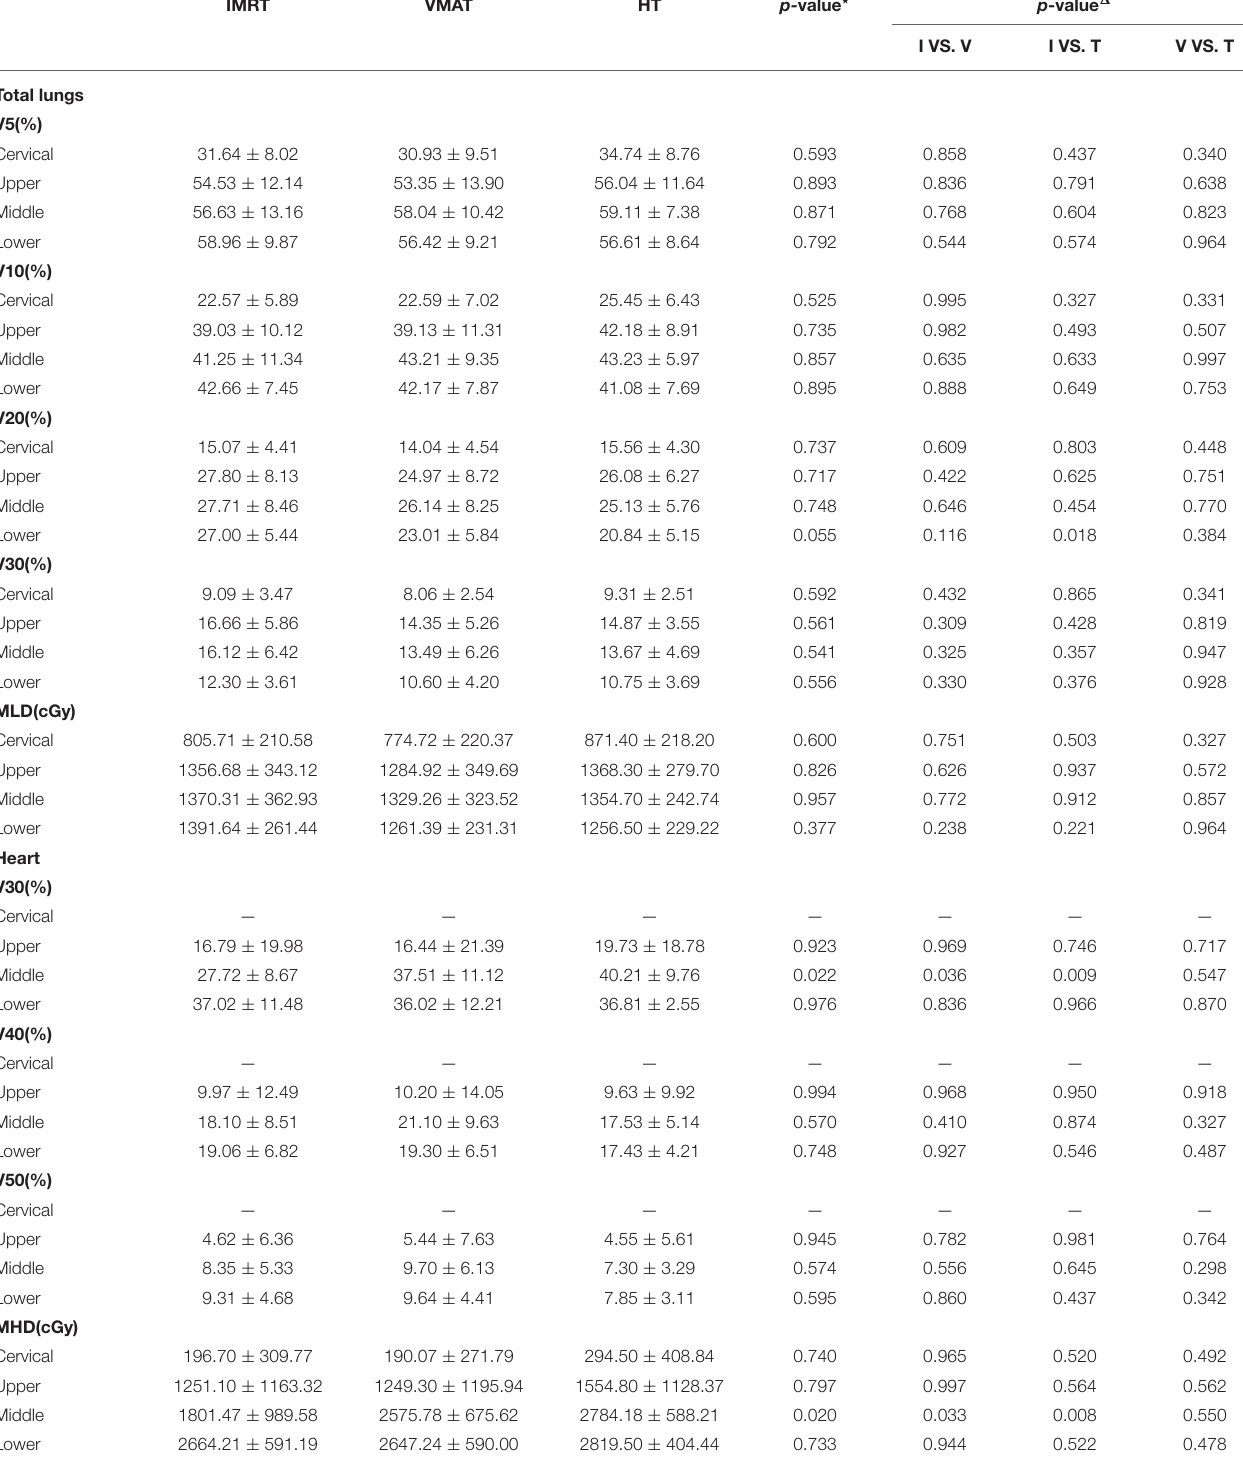
TABLE 4 | Dosimetric results for OARs in cervical, upper, middle, and lower thoracic EC. IMRT VMAT HT p- value ⋆ p -value 1